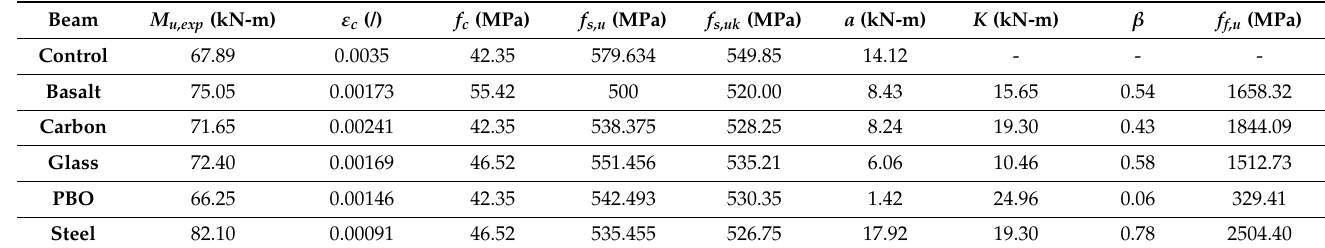
Table 4. Analytical model